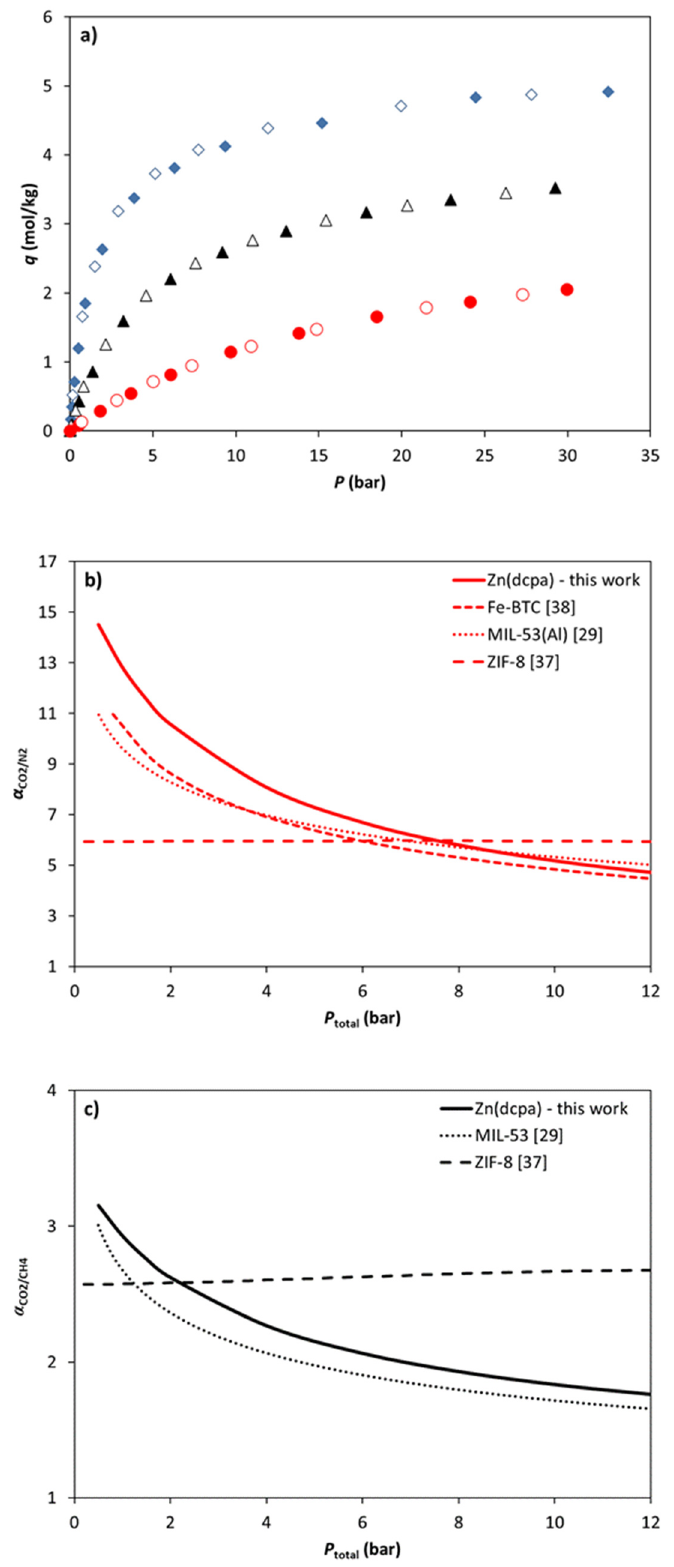
Figure 10. ( a ) Adsorption equilibrium isotherms of CO 2 ( ♦ ), CH 4 ( ▲ ), and N 2 ( ● ) on Zn(dcpa) at 303 K. Filled and empty symbols represent adsorption and desorption data, respectively; ( b ) CO 2 /N 2 and ( c ) CO 2 /CH 4 equilibrium selectivity at 303 K as a function of pressure for Zn(dcpa) and commercial MOFs MIL-53(Al) [31], ZIF-8 [44], and Fe-BTC [45].